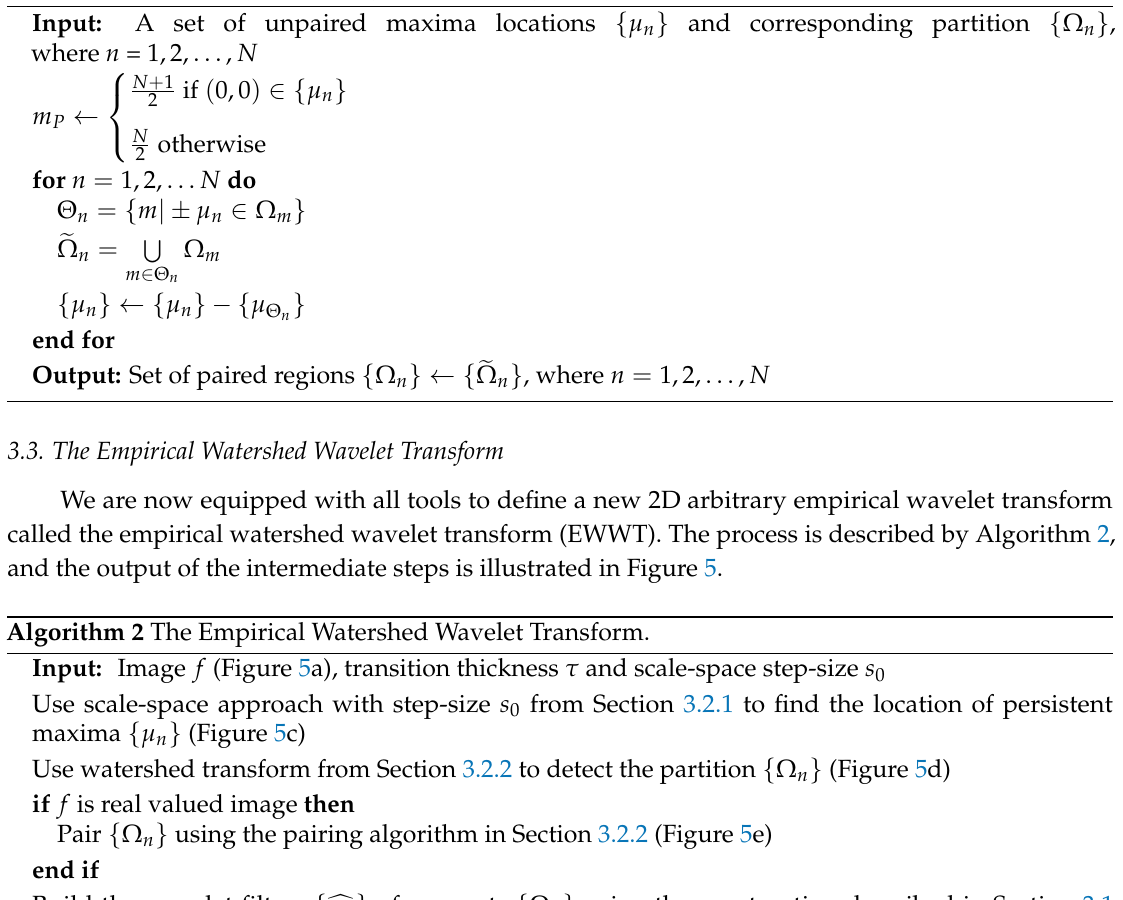
Algorithm 1 Boundary pixel assignment and regions symmetrization.